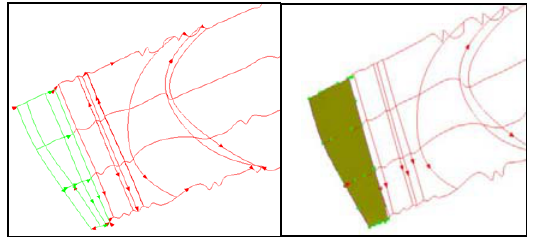
Figure 7: Demo figure of Fitting curve 2.2.4